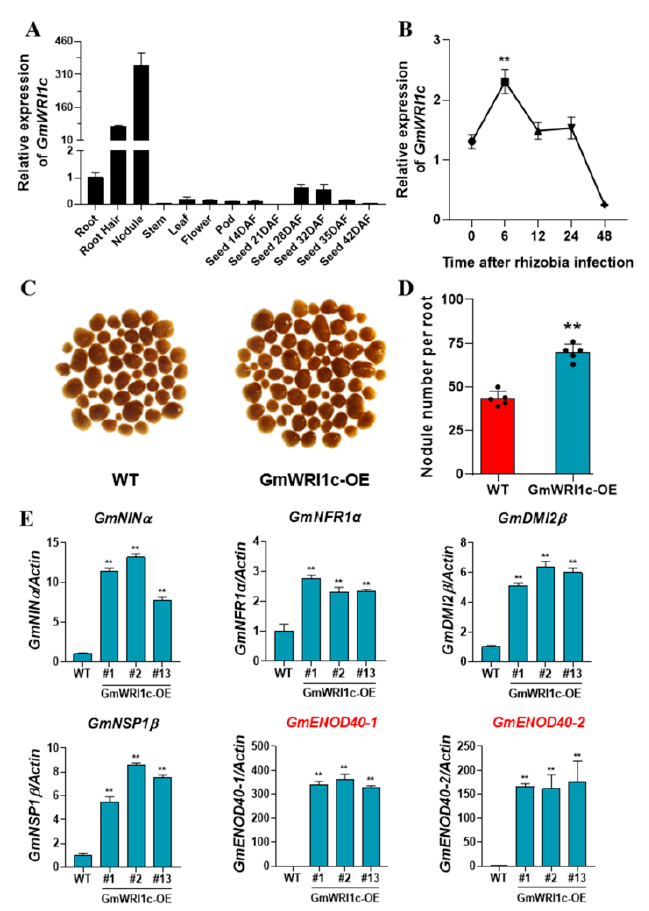
Figure 4. Effects of GmWRI1c on nodulation in soybean. ( A ) Transcript profiles of GmWRI1c in different tissues. ( B ) Transcript levels of GmWRI1c in roots after rhizobial infection. ( C , D ) Number of root nodules in GmWRI1c -OE transgenic hairy roots compared with control ( n = 5). ( E ) Transcript level of gene encoding nodule factor in transgenic nodules. Values are means ± SD from three technical replicates. ** p < 0.01 (Student’s t -test).